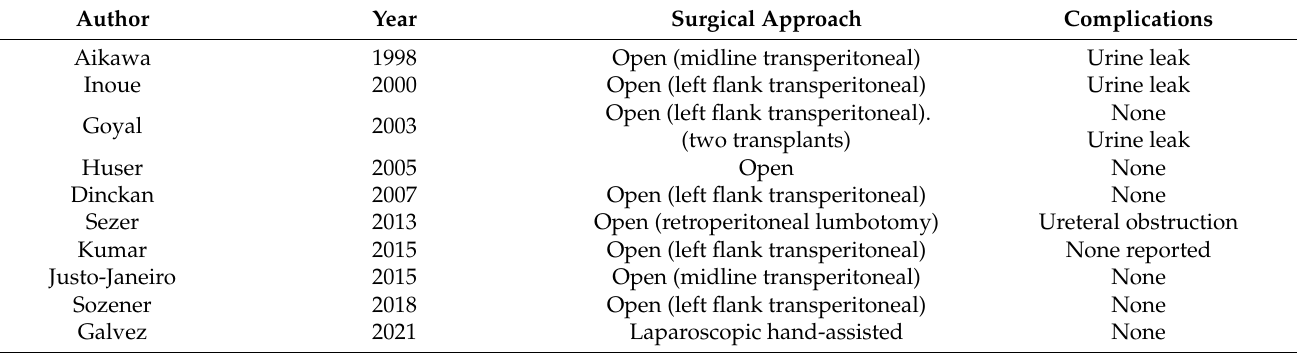
Table 1. Living donor horseshoe kidney transplants described in the